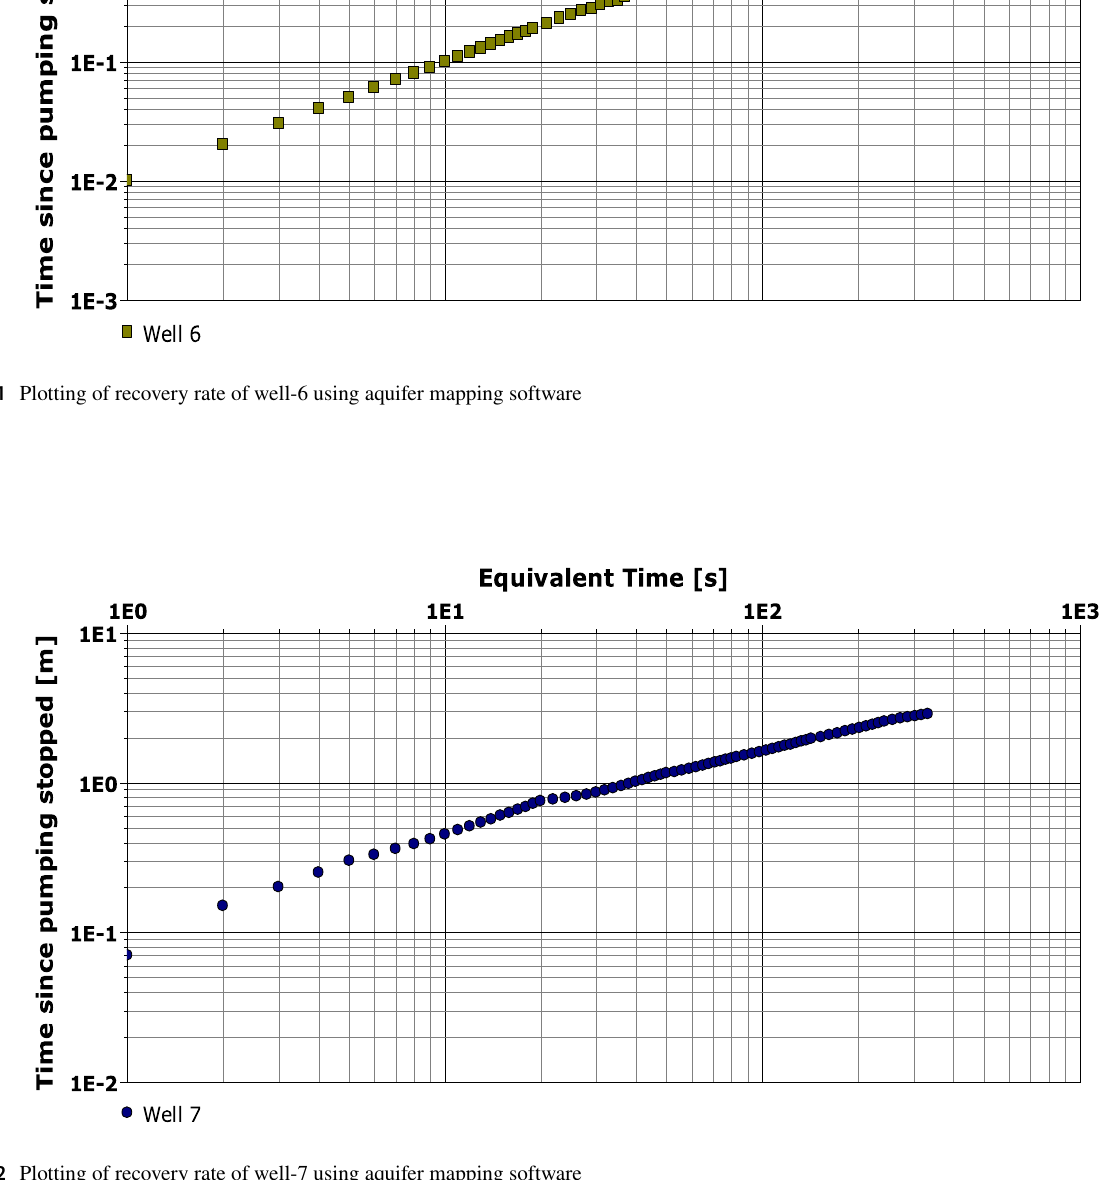
Fig. 12 Plotting of recovery rate of well-7 using aquifer mapping